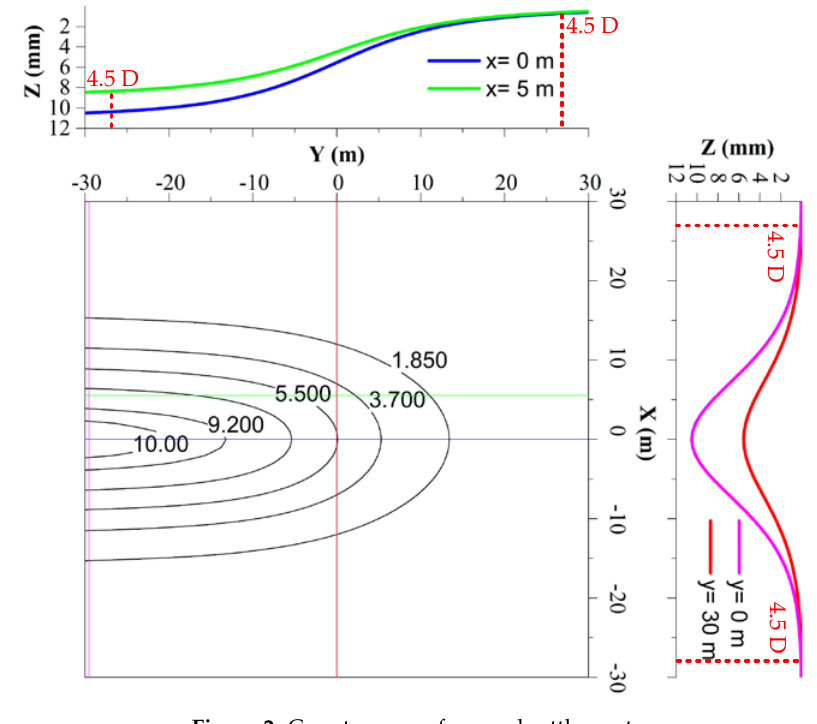
Figure 2. Counter map of ground settlement. Appl. Sci. 2019 , 9 , x FOR PEER REVIEW